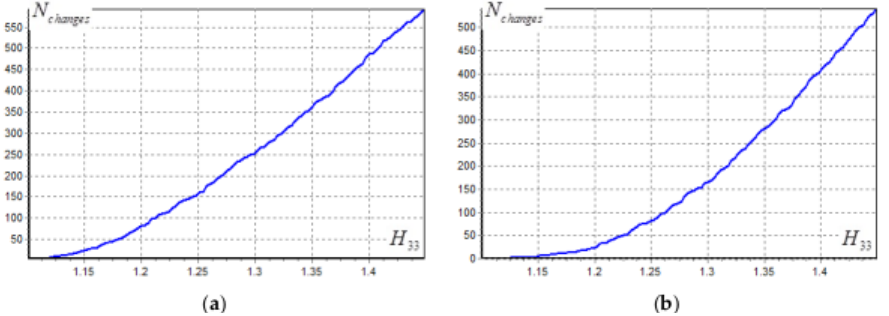
Figure 4. Number of contacting grain changes versus strain H 33 for the initial strain rate: ( a ) D 0 = 3.33 · 10 − 4 s − 1 , ( b ) D 0 = 3.33 · 10 − 3 s − 1